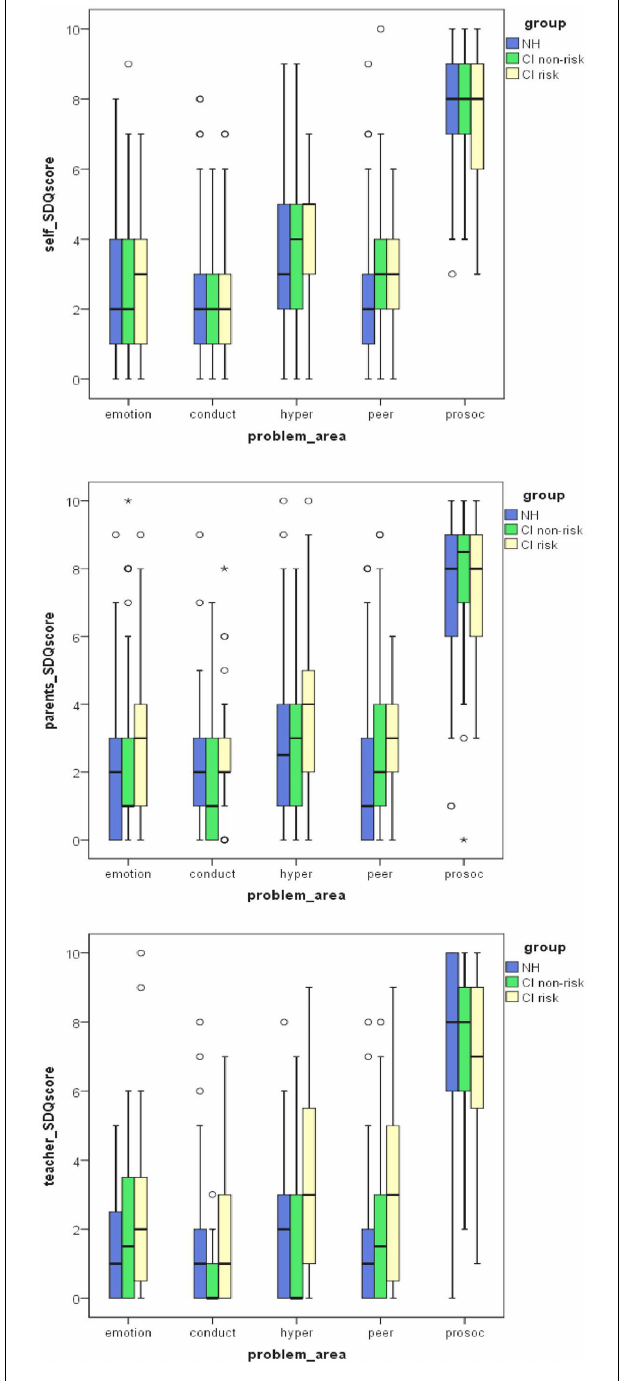
FIGURE 1 | Box-plots of SDQ self- parent- and teacher-ratings for emotional symptoms, conduct problems, hyperactivity and peer problems as well as pro-social behavior in normally hearing (NH) adolescents and CI adolescents with (risk) and without (non-risk) additional handicaps. CI adolescents without additional handicaps differ from NH adolescents only in their self-rated peer problems. CI adolescents with additional risks differ from NH adolescents not only in peer problems, but also in hyperactivity and from CI adolescents without additional risks in conduct problems. Higher scores indicate more problems. Circles ( ◦ ) and asterisks ( * ) indicate extreme cases and